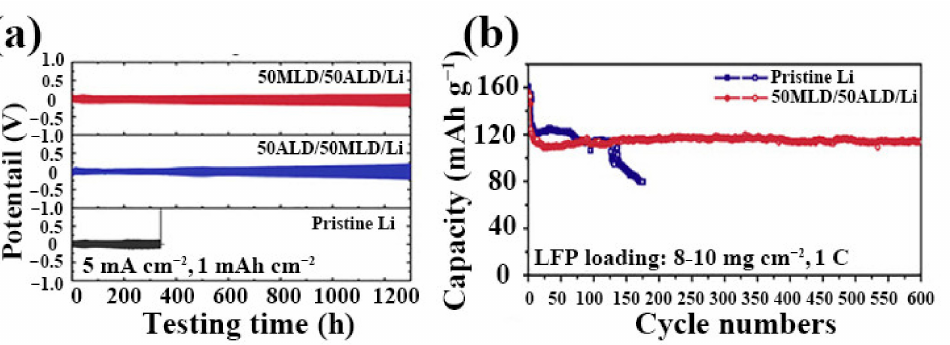
Figure 13. ( a ) Voltage hysteresis profiles of symmetric cells in ether electrolyte and ( b ) cycling performance of full Li-LFP cells using pristine Li foil and 50MLD/50ALD/Li as anode electrode at 1 C (1 C = 170 mA g − 1 ) [131]. Reproduced with permission [131]. Copyright 2019,